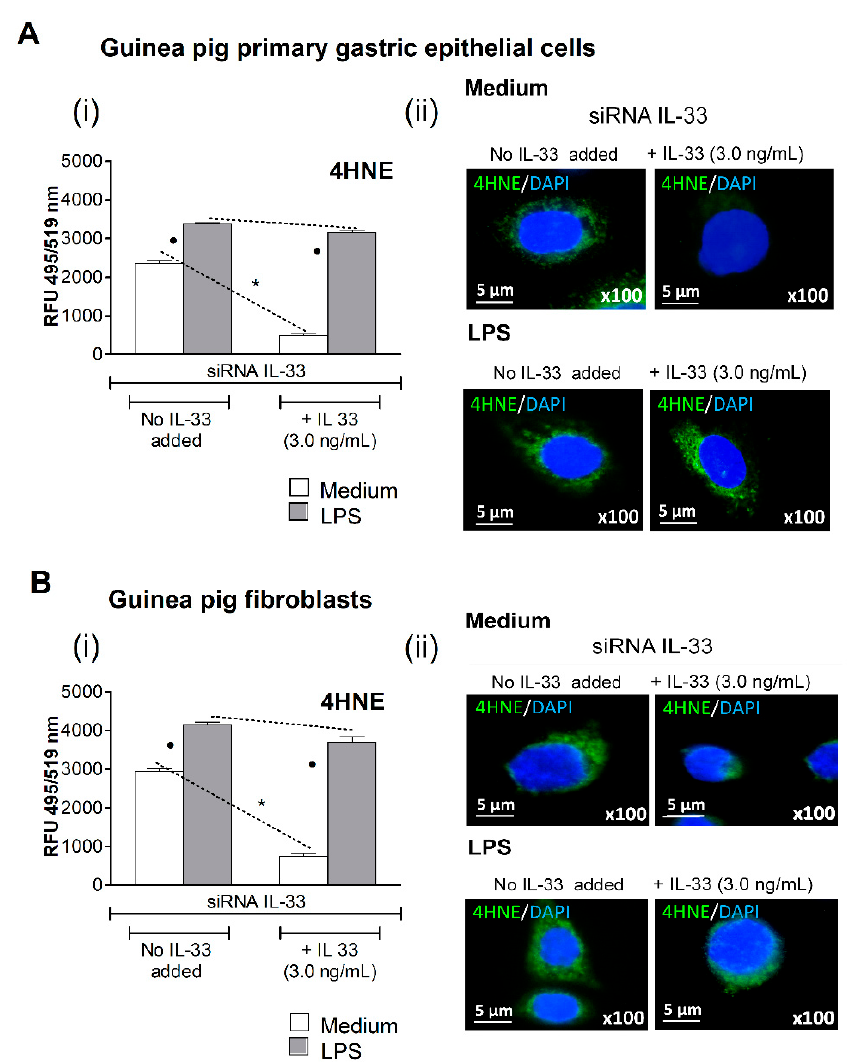
Figure 2. Oxidative stress assessment. The oxidative stress intensity was assessed on the basis of the relative fluorescence of 4-hydroxy-2-nonenal (4HNE), detected by immune staining with anti-4HNE antibodies. Primary gastric epithelial cells ( A ) or fibroblasts ( B ), transfected with siRNA IL-33, not exposed or exposed to H. pylori lipopolysaccharide (LPS), 25 ng/mL, in the presence or absence of exogenous IL-33 (3.0 ng/mL), were assessed for 4HNE. ( i ) Fluorescence intensity of 4HNE in gastric epithelial cells or fibroblasts was measured using the ImageJ software version 1.48v (National Institute of Health, United States). ( ii ) Representative images of primary gastric epithelial cells or fibroblasts stained for 4HNE and photographed with a fluorescence microscope (Axio Scope A1, Zeiss, Germany) are shown. Cells were treated with 4 ′ ,6-diamidino-2-phenylindole (DAPI), for nuclear staining. Results are shown as median with the range of five experi- ments performed in triplicate for each experimental variant. Statistical analysis was performed using the nonparametric Mann-Whitney U test with significance at p < 0.05. * cells not treated with LPS H. pylori, in medium without IL-33 vs. cells not exposed to LPS H. pylori , in medium with IL-33; ● cells not treated with LPS H. pylori vs. cells treated with LPS H. pylori , in medium without or with IL-33